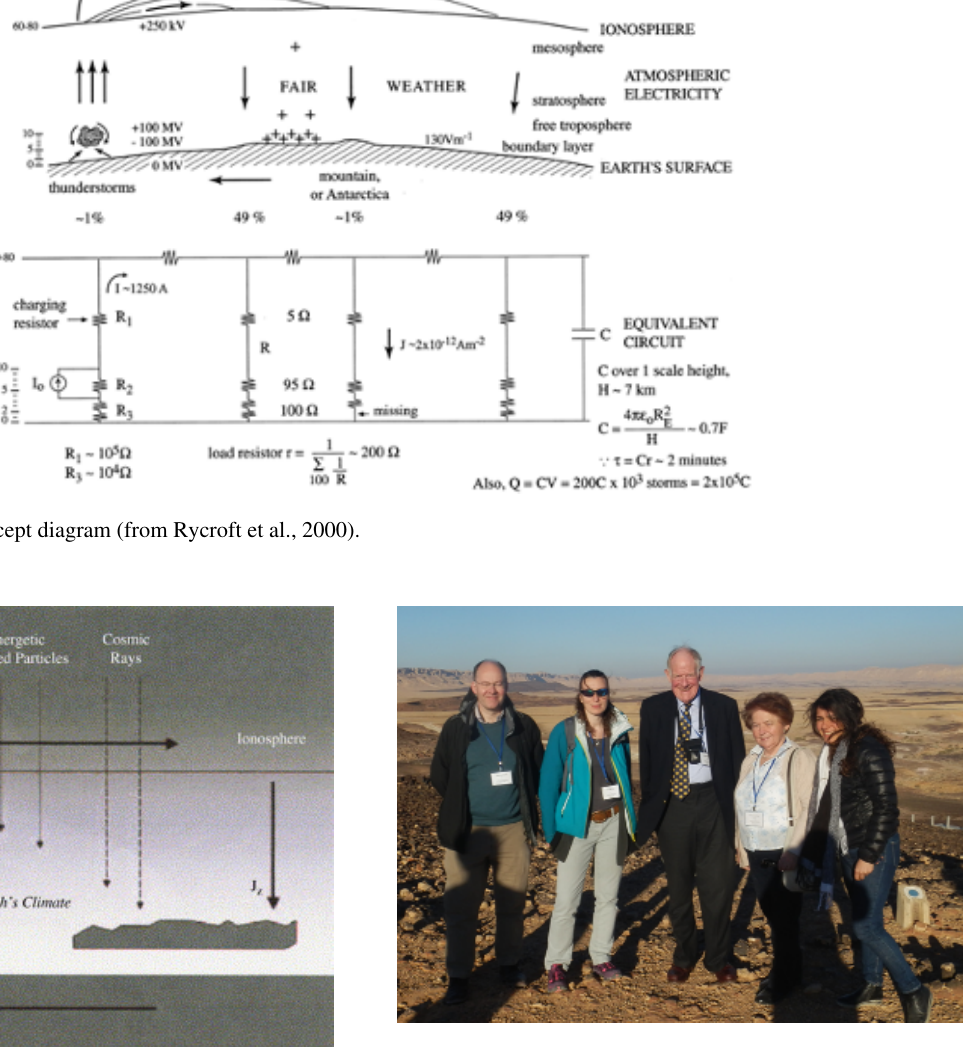
Figure 8. Discussing atmospheric electricity in the Negev Desert, February 2017, whilst attending the “Batsheva de Rothschild Work- shop on the Atmospheric Global Electric Circuit” at Mitzpe Ra- mon. (Left to right: Giles Harrison, Keri Nicoll, Michael Rycroft, Gabriela Sartori, and Hripsime